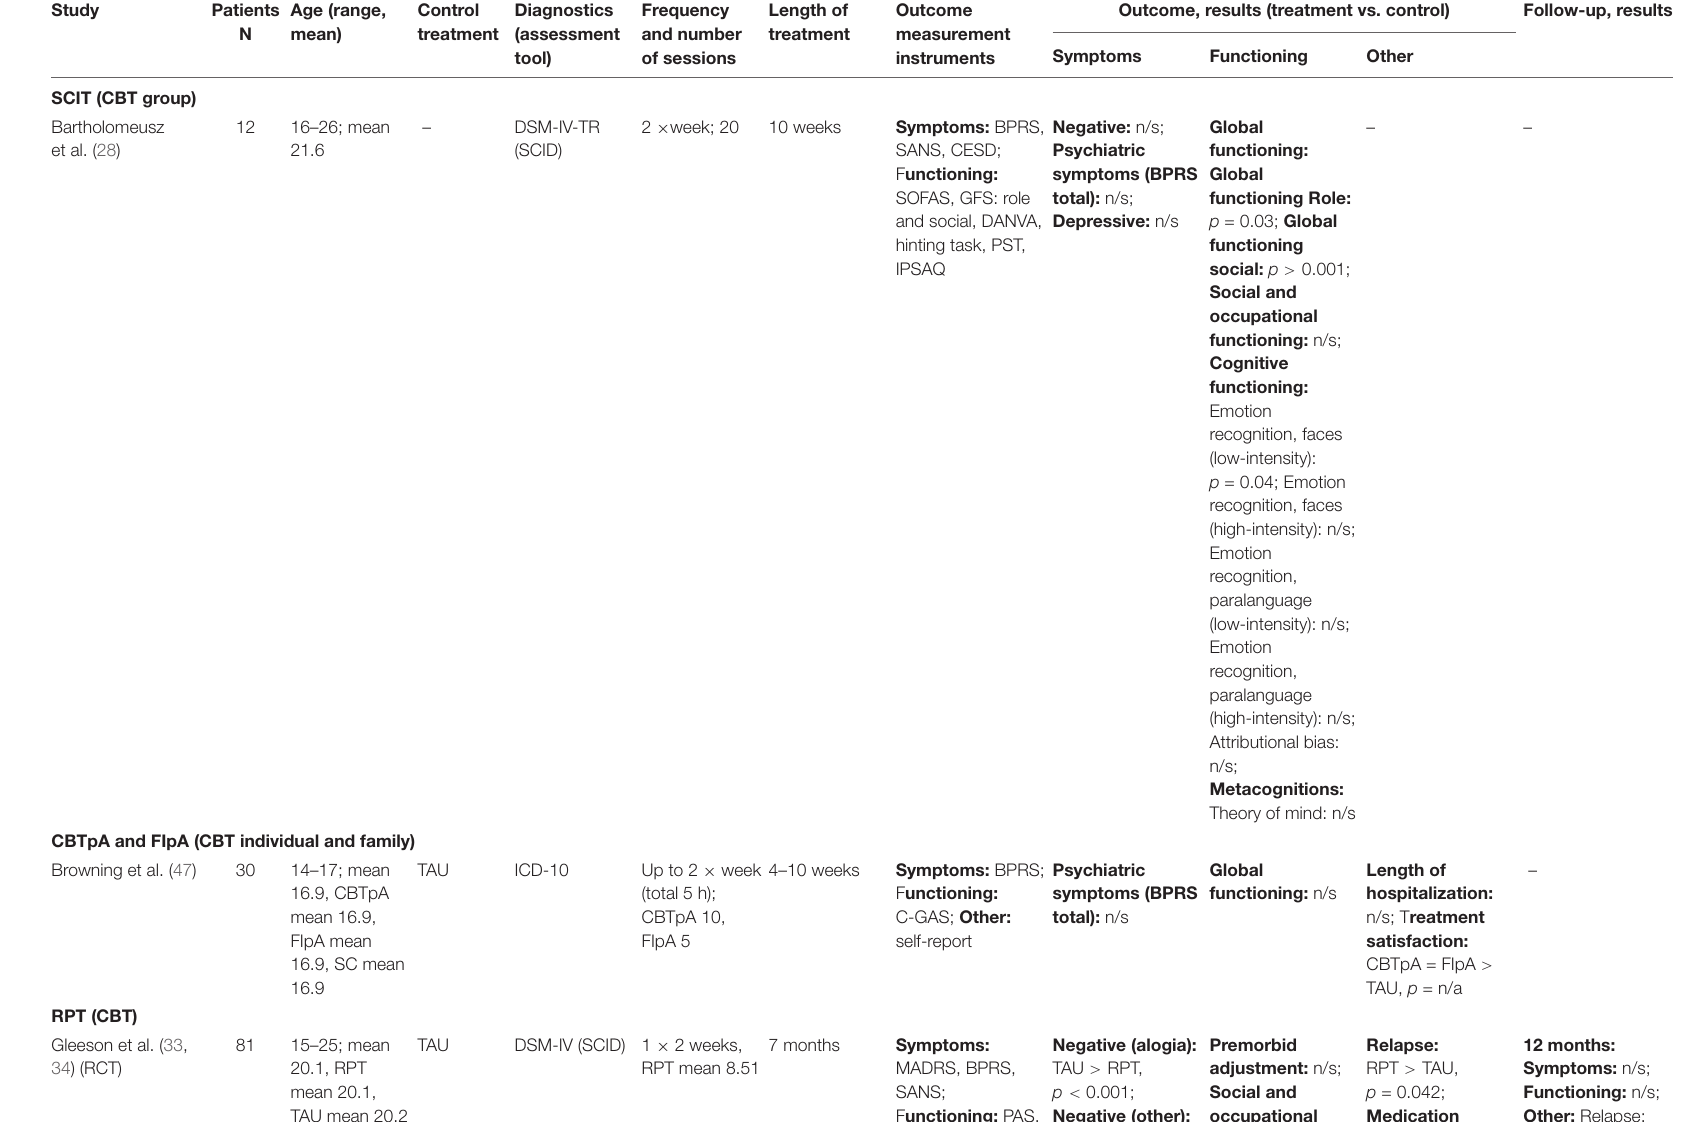
TABLE 2 | Studies concerning psychological interventions based on cognitive, cognitive-behavioral, or behavioral therapies for adolescents and young adults with